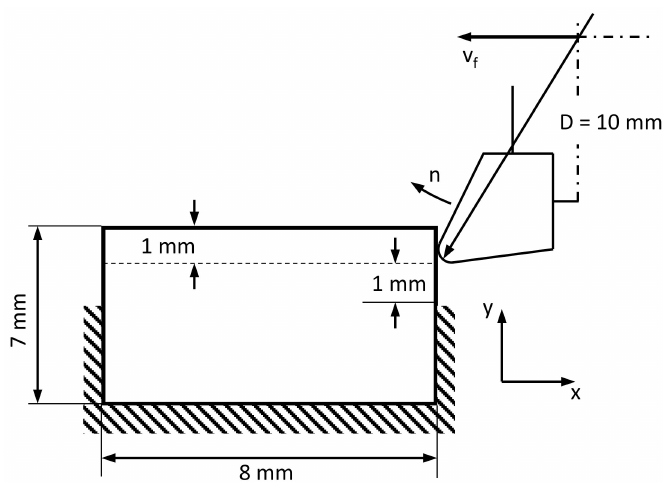
Figure7. SchematicrepresentationoftheboundaryconditionsintheFEsimulationofperipheralmilling.